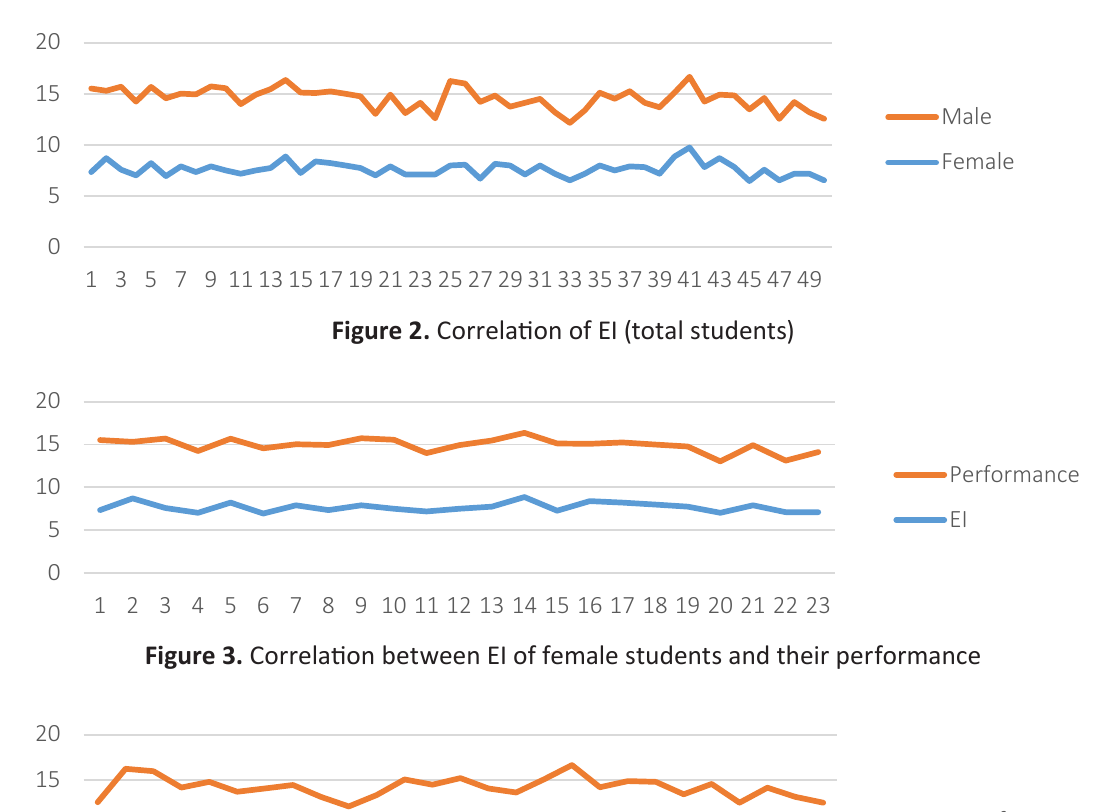
Figure 3 and Figure 4, gender-wise. The average EI score of female students is 96.13 out of 125, which is compared to male students is high.